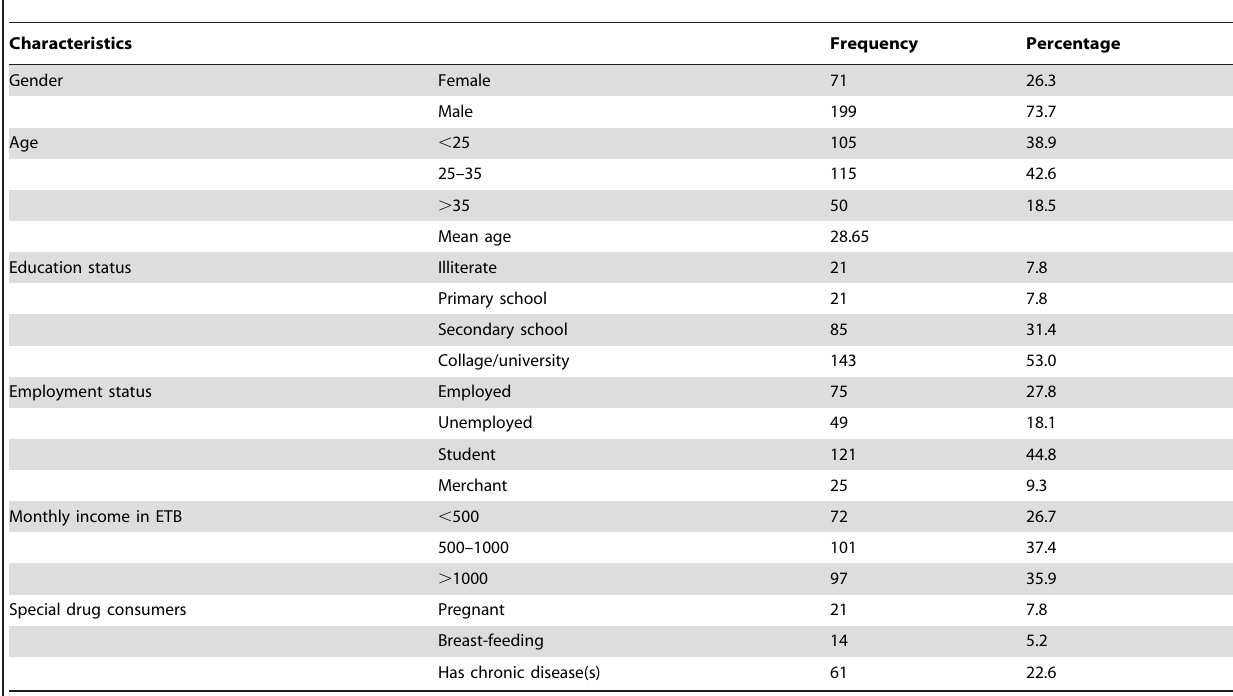
Table 1. Socio-demographic characteristics of study participants